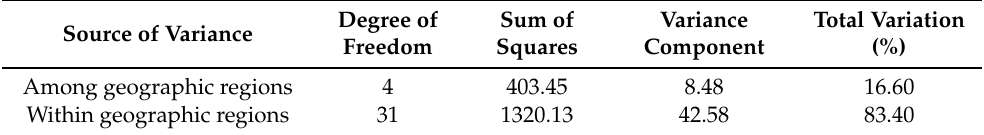
Table 4. Analysis of molecular variance (AMOVA) of five geographic regions.